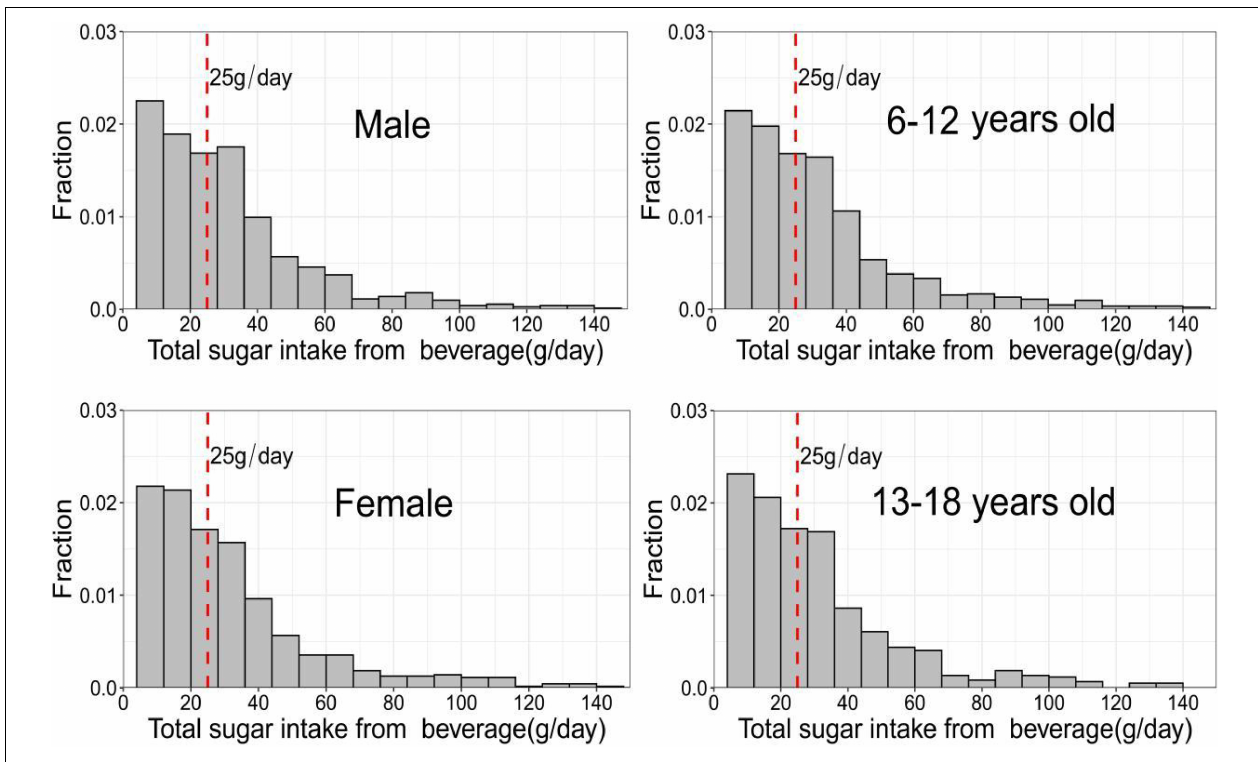
FIGURE 1 | Sugar intake from beverages in different age and gender